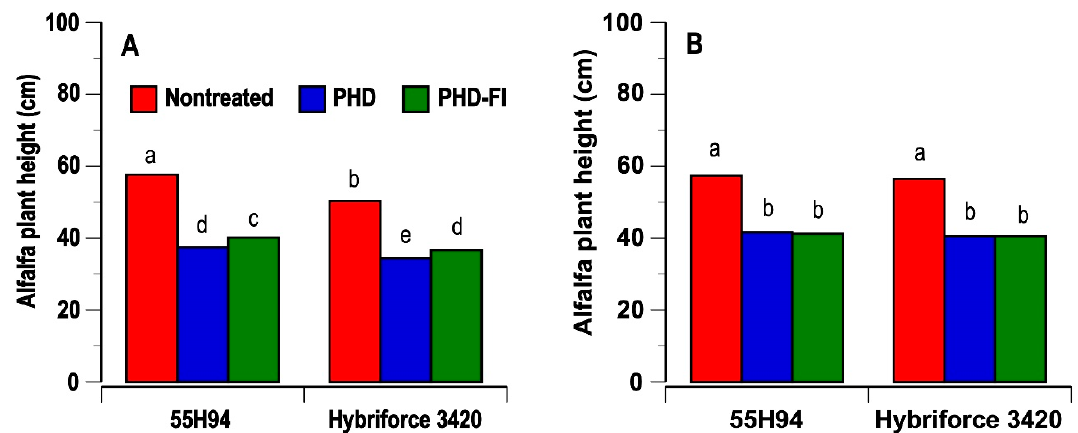
Figure 2. Plant height of interseeded alfalfa in 2017 (A) and 2018 (B), as influenced by variety and agrichemical treatments. Agrichemical treatments applied to alfalfa during establishment consisted of a nontreated control, prohexadione (PHD), and prohexadione followed by fungicide and insecticide (PHD-FI). Data were collected about 2.5 weeks after PHD application and were averaged across corn populations. Least square means within each panel with no common letter are significantly different ( p = 0.05).